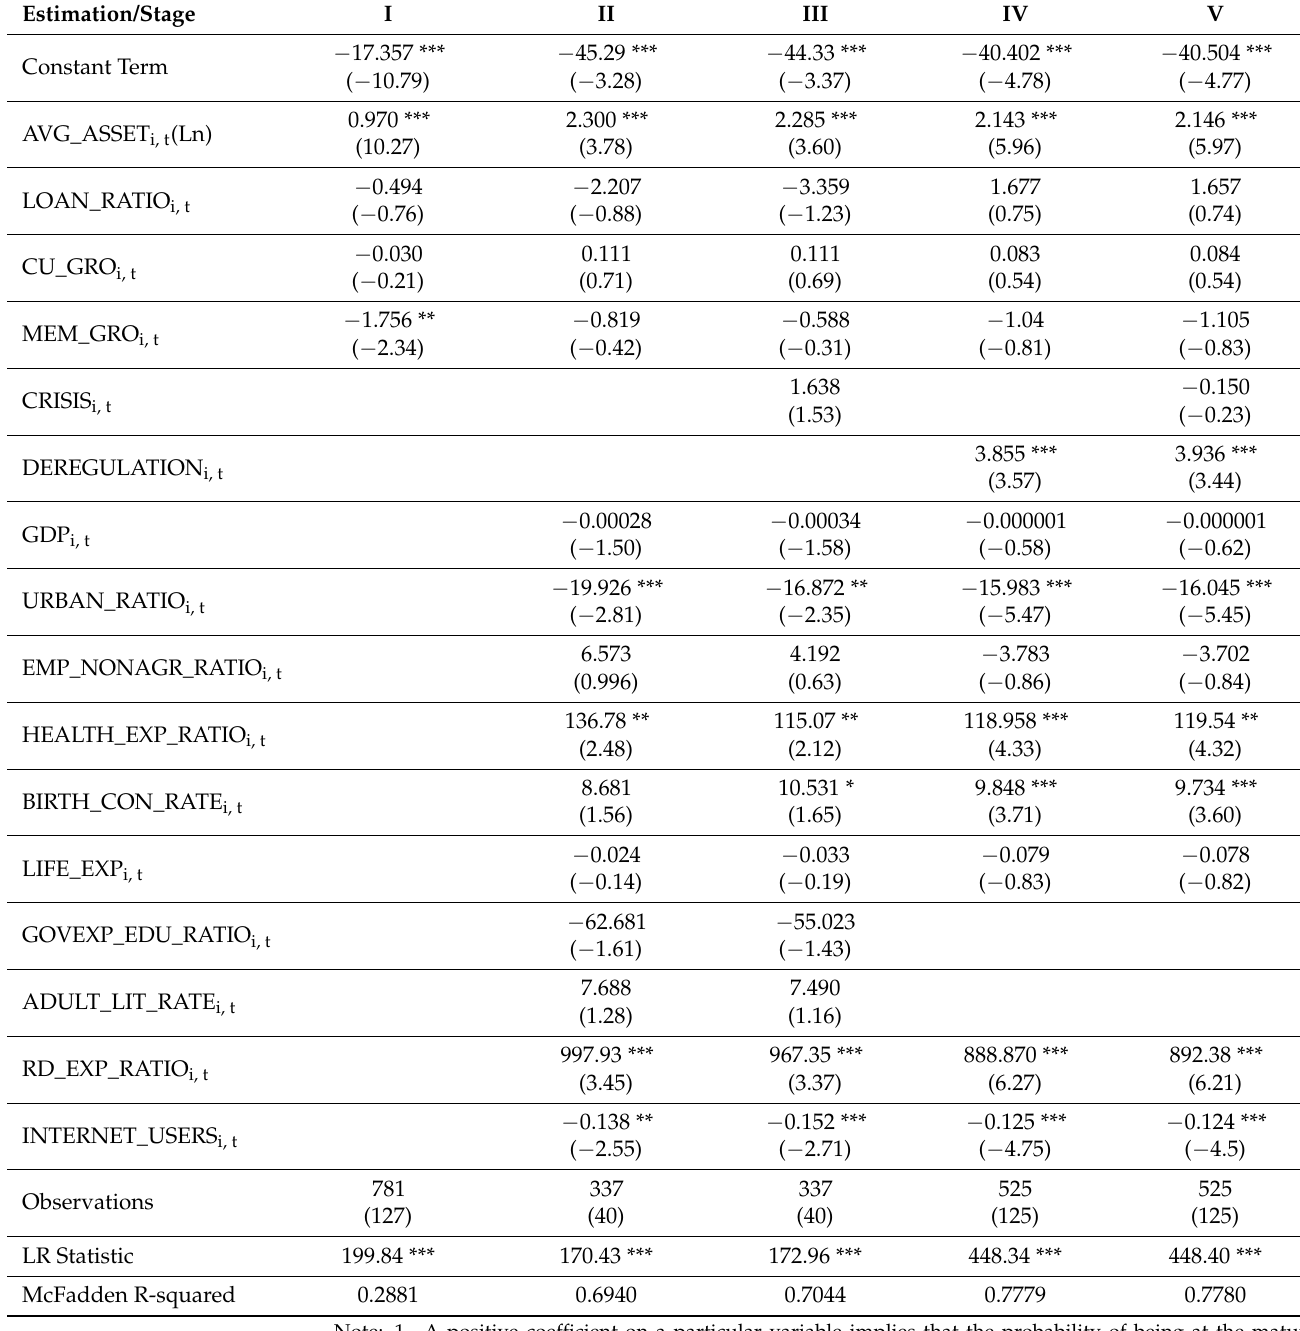
Table 8. Estimated results of the binary logistic regression (from the transition stage to the ma- ture